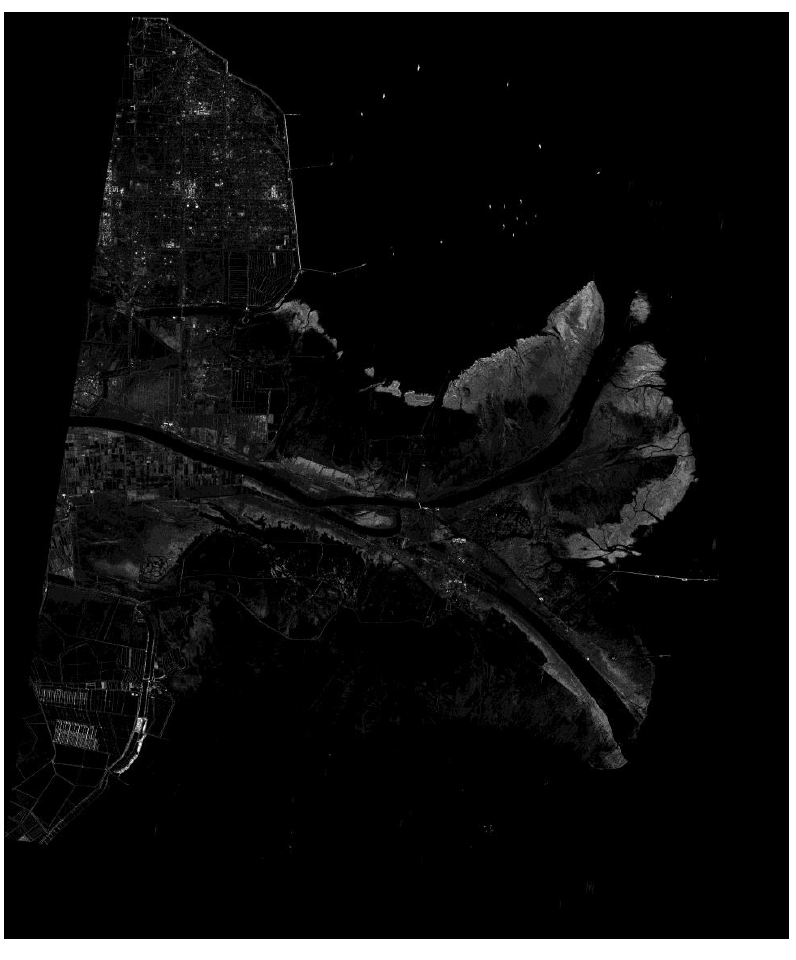
Figure 10. The GF-3 ultra-fine stripmap imagery of the estuary of Huanghe River China (acquired at 15 February 2017).